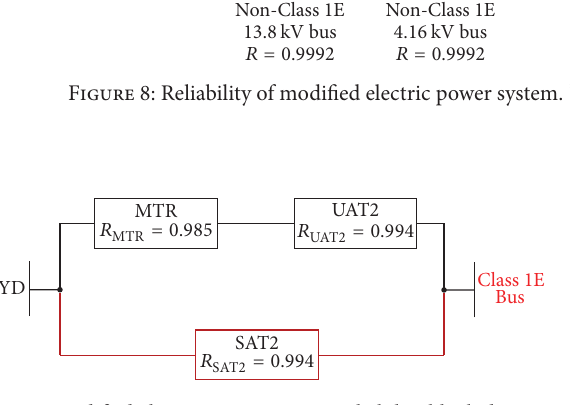
Figure 9: Modified electric power system reliability block diagram for Class 1E